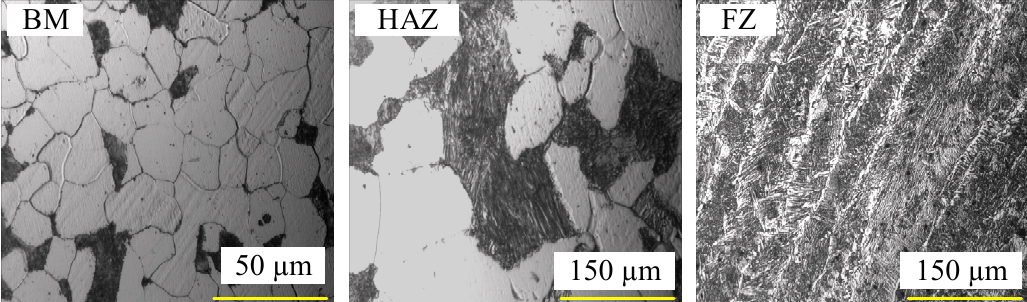
Figure 3. Weld toe three-zone section metallography